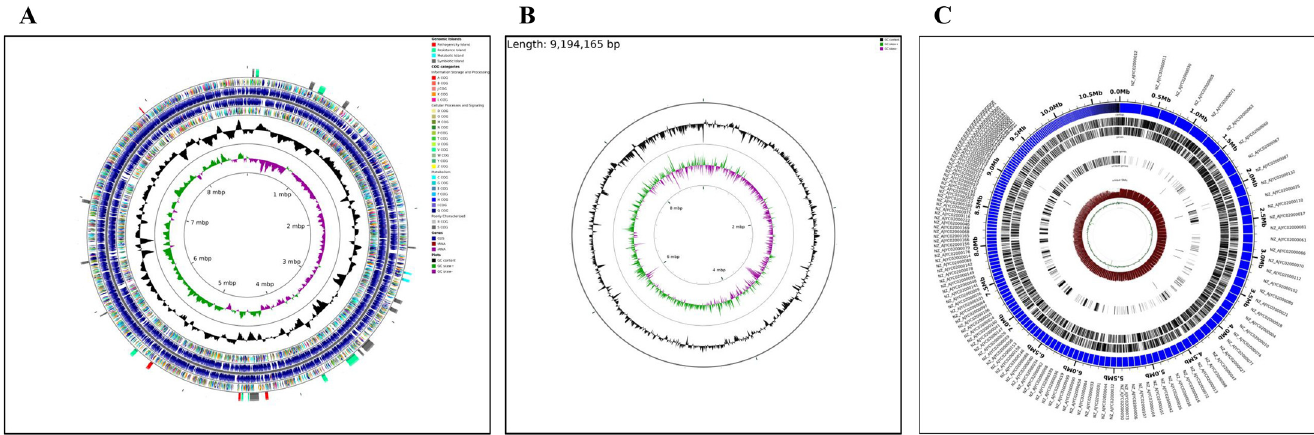
Fig 1. Genomic map of R . opacus strain M213. Shown are A, circular genome map of Rhodococcus opacus strain M213 with the first (outermost) and fourth rings depicting COG categories of protein coding genes on the forward and reverse strands, respectively. The second and third rings show the locations of protein coding, tRNA, and rRNA genes on the forward and reverse strands, respectively. The black plot depicts GC content with the peaks extending towards the outside of the circle representing GC content above the genome average, whereas those extending towards the center mark segments with GC content lower than the genome average. The innermost plot depicts GC skew. Both base composition plots were generated using a sliding window of 50,000 nt; B, genomic map of R . opacus strain M213 shown with the draft genome sequence re-ordered relative to R . jostii strain RHA1 as a reference organism; (C), A circleator-generated genomic map showing the total genes, single nucleotide polymorphisms (SNPs), along with the unique and core genome fragments of R . opacus strain M213 relative to other rhodococcii.